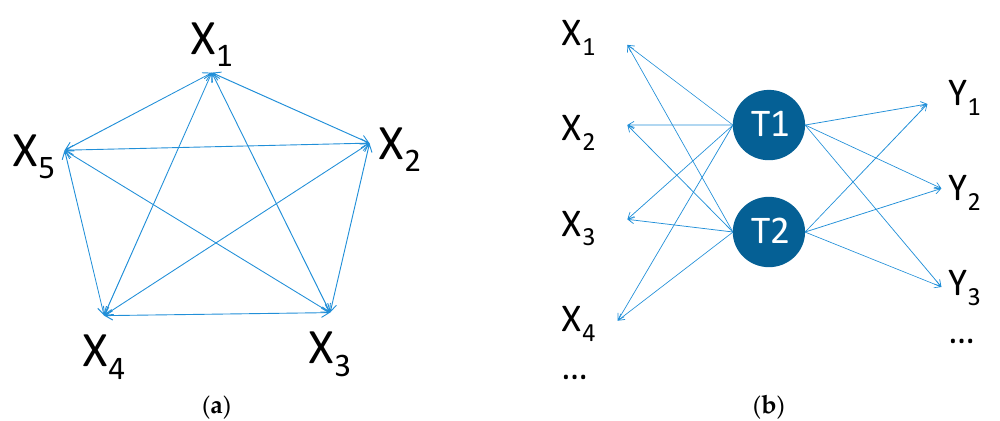
Figure 2. Graphical illustration of the model structures underlying: ( a ) classical multivariate approaches and ( b ) latent variable approaches.